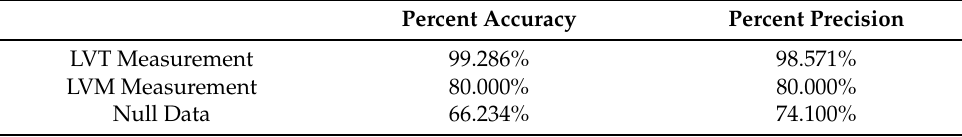
Figure 6. Hourly percent of missing data on 2 July 2021. Table 2. Percent accuracy and precision of model